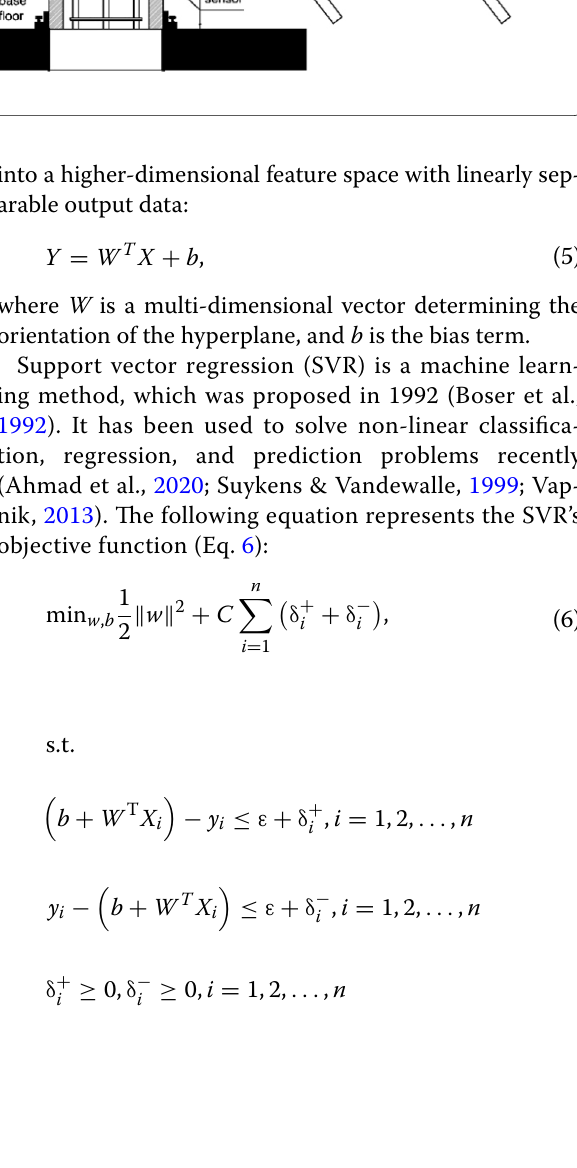
Fig. 5 Schematic illustration of the erecting